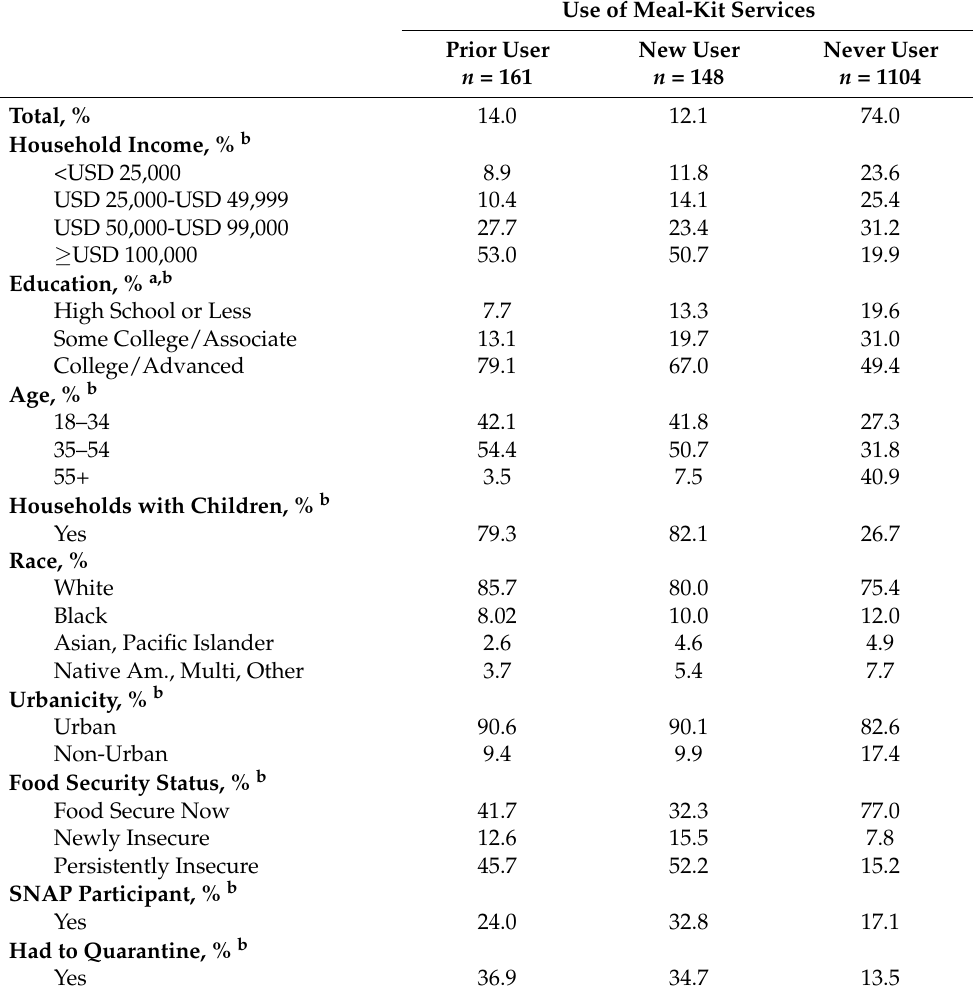
Table 1. Weighted Distribution of Characteristics of Participants in the National Food Access and COVID Research Survey, by Meal-Kit Delivery Service Use During the Early Months of COVID-19